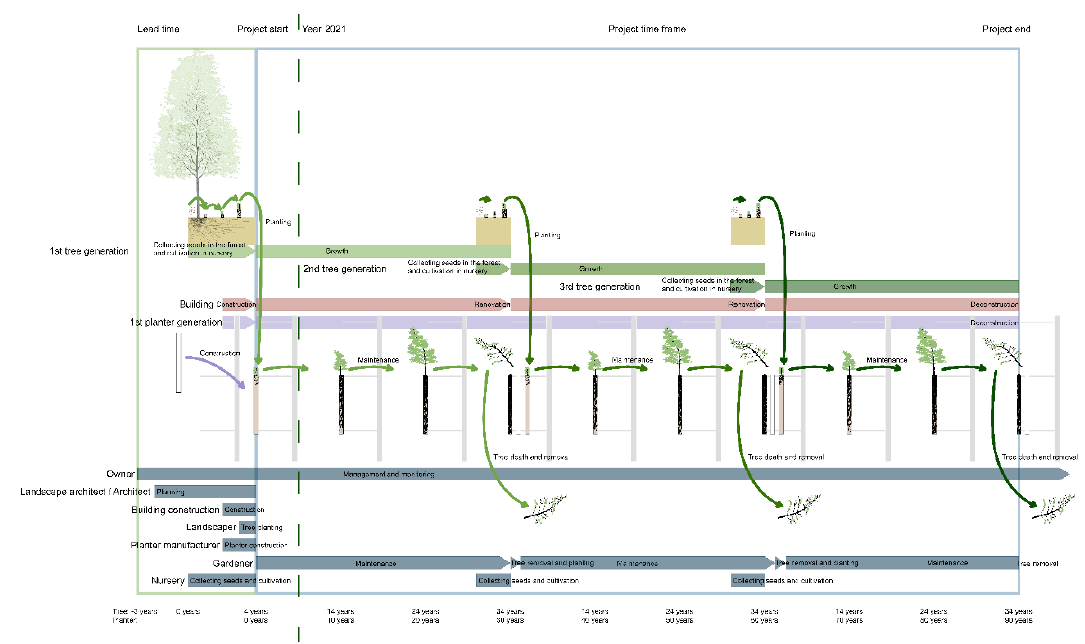
Figure 5. Time diagram of “Tour de la biodiversité”.